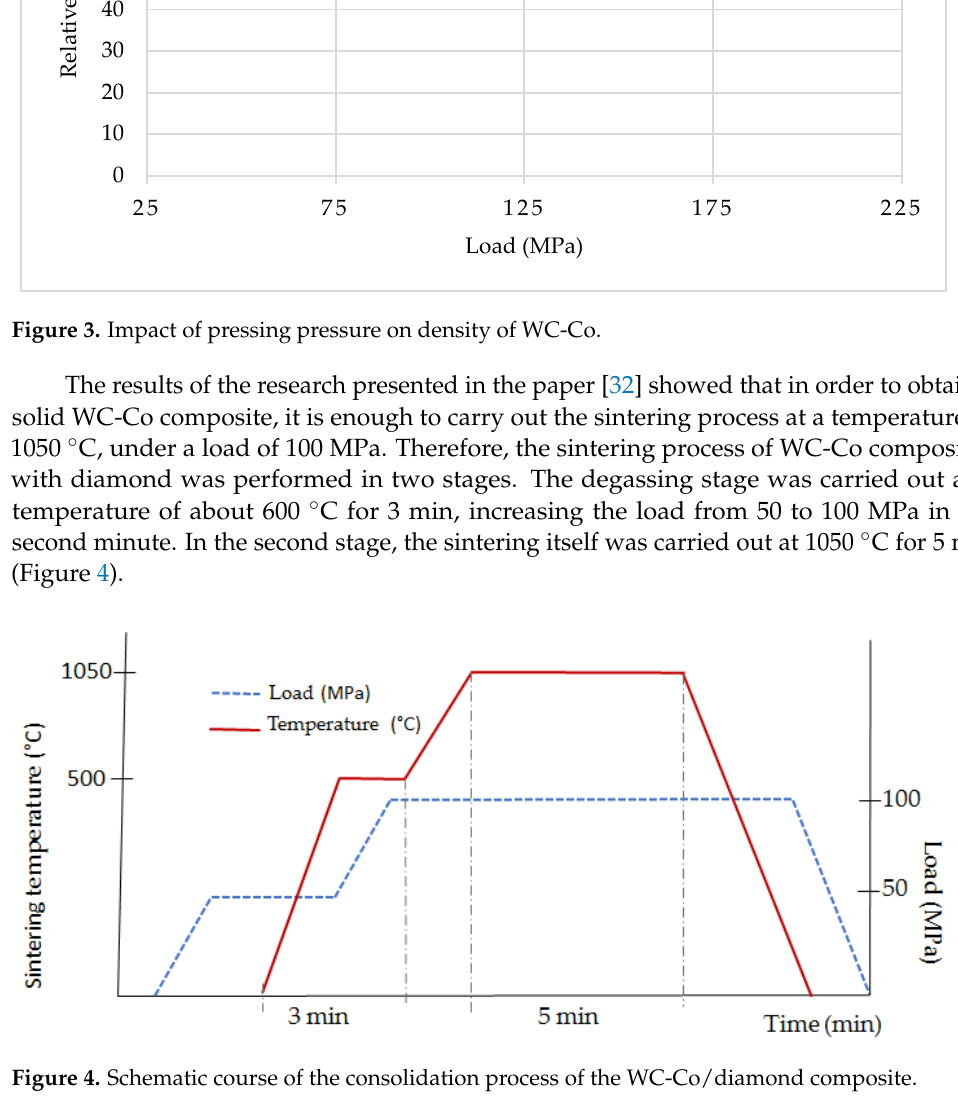
Figure 4. Schematic course of the consolidation process of the WC-Co/diamond composite.